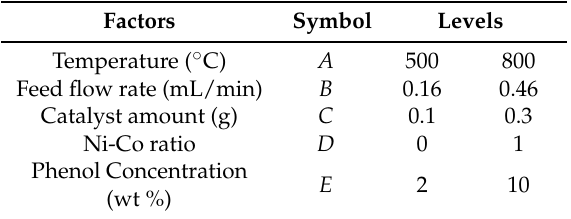
Table 1. Selected factors and levels for the experimental study.